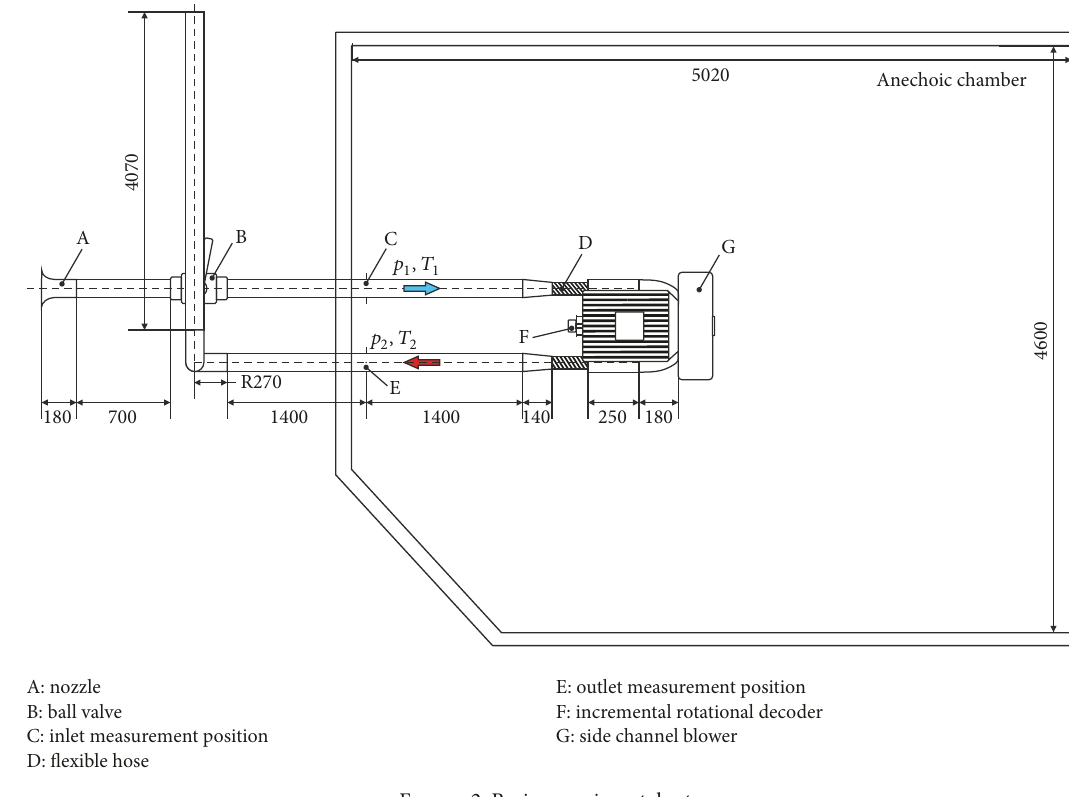
Figure 2: Basic experimental